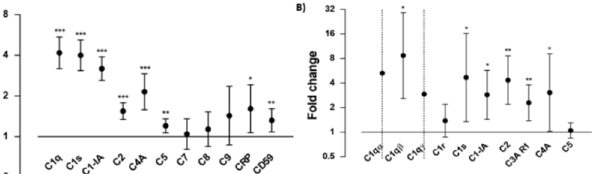
Fig 1. Gene expression analysis showing upregulation of complement associatedgenes in two independent data sets. Figs show fold change of group mean expressionvalues with 95% confidence intervalfor astrocytoma grade IV vs. non-tumor brain in a data set from a publicly available database(Fig 1A) and our own institution(Fig 1B). Confidence intervals for C1 α and C1q γ lie outsidethe scale. Significance levels are indicatedas * p < 0.05, ** p < 0.01,and *** p < 0.001.